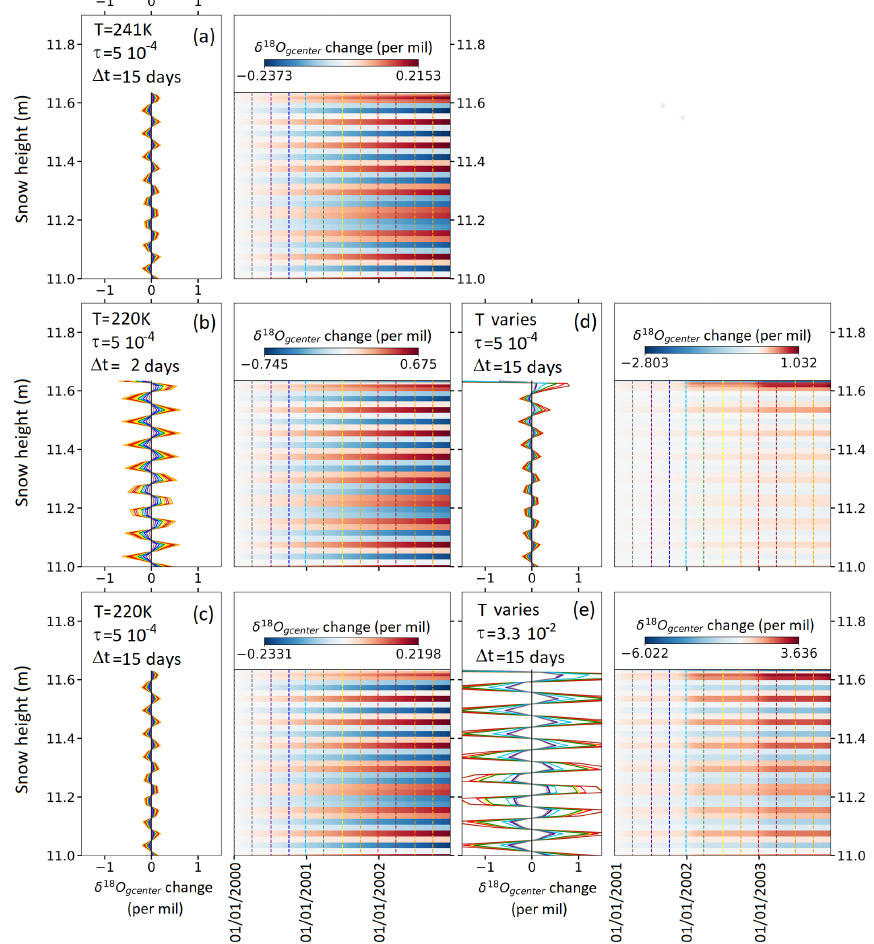
Figure 10. Test of the sensitivity of the model to the ratio of mass between the surface and grain center compartments and to the interval of mixing between the two compartments (Dome